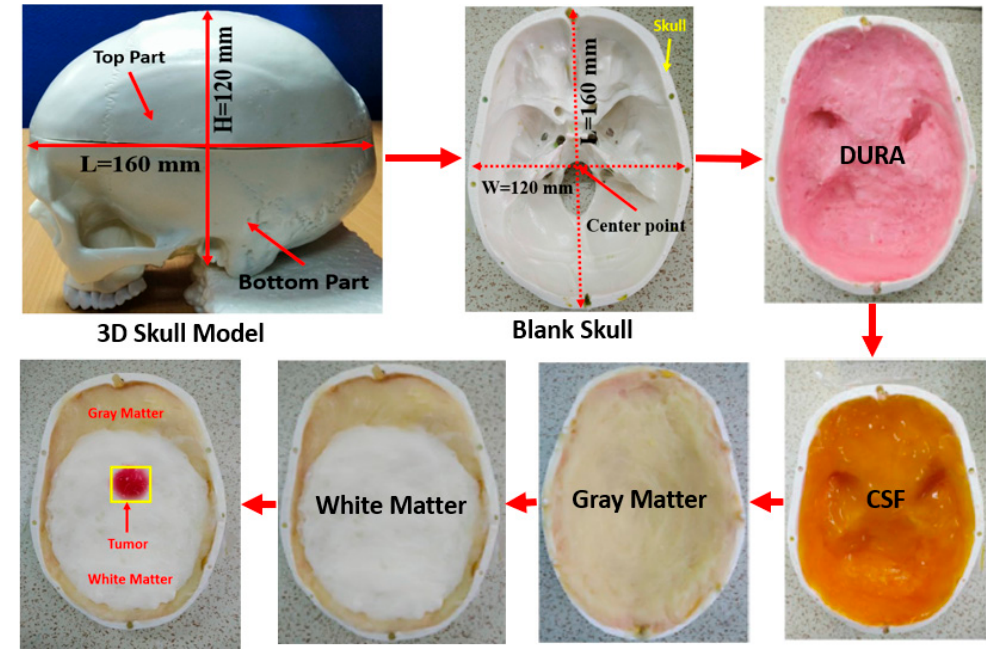
Figure 4. Phantom’s composition process using fabricated four tissues.